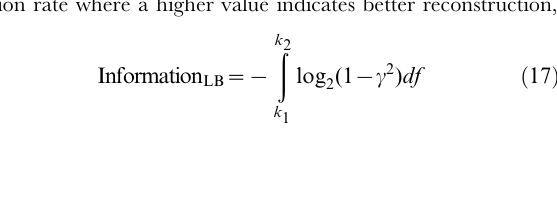
PLOS Computational Biology |